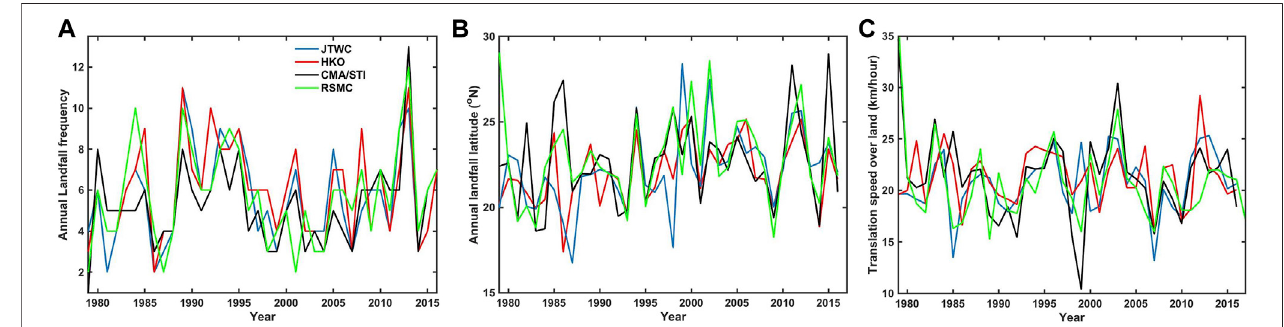
FIGURE 1 | Historical TC characters of (A) TC landfall frequency, (B) latitude of typhoon landfall, and (C) TC translation speed, from the converted JTWC, HKO, CMA/STI, and RSMC best track data, respectively.